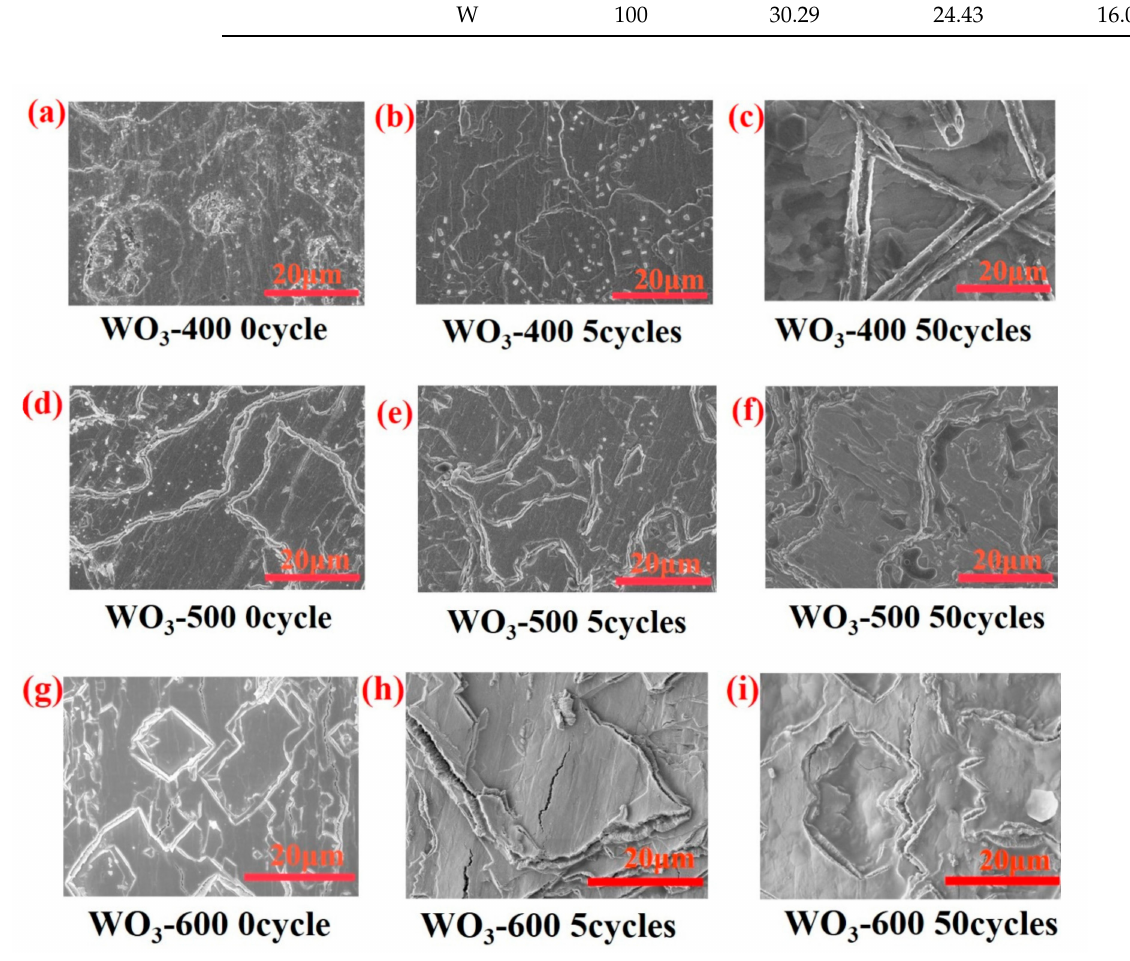
Figure 8. SEM images of WO 3 -X (X = 400, 500, 600). ( a ) ECD(WO 3 -400) after 0 cycle; ( b ) ECD(WO 3 - 400) after 5 cycles; ( c ) ECD(WO 3 -400) after 50 cycles; ( d ) ECD(WO 3 -500) after 0 cycle; ( e ) ECD(WO 3 - 500) after 5 cycles; ( f ) ECD(WO 3 -500) after 50 cycles; ( g ) ECD(WO 3 -600) after 0 cycle; ( h ) ECD(WO 3 - 600) after 5 cycles; ( i ) ECD(WO 3 -600) after 50